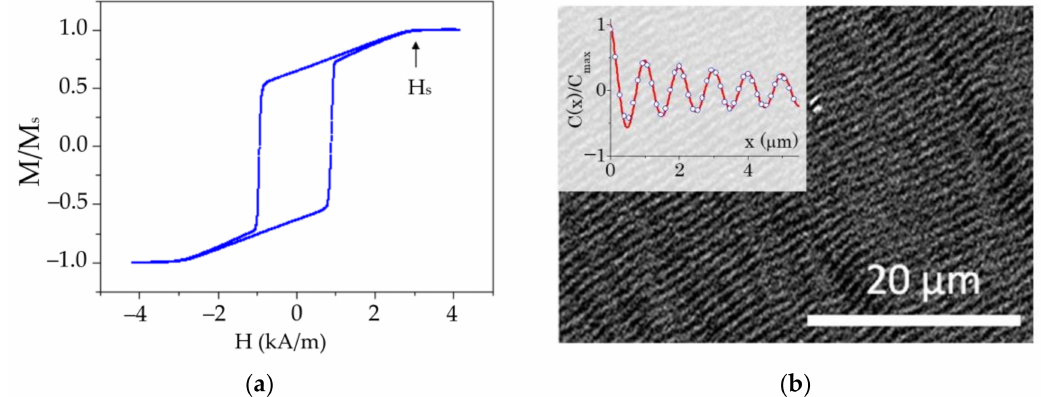
Figure 4. Hysteresis loop of the Py film (500 nm), field applied in the film plane at an angle of 0 ◦ to in-plane EA ( a ). The stripe magnetic domain structure in the zero external magnetic field. The inset shows the correlation function in the direction across the stripe structure to the estimate stripe domain width D m = 260 ± 20 nm ( b